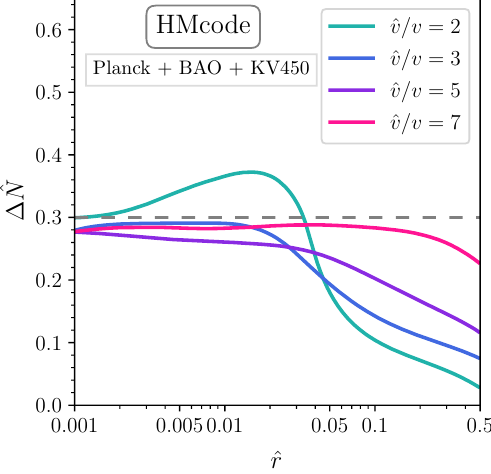
Figure 17. Constraints from Planck+BAO+KV450 datasets with non-linear power spectrum corrections from